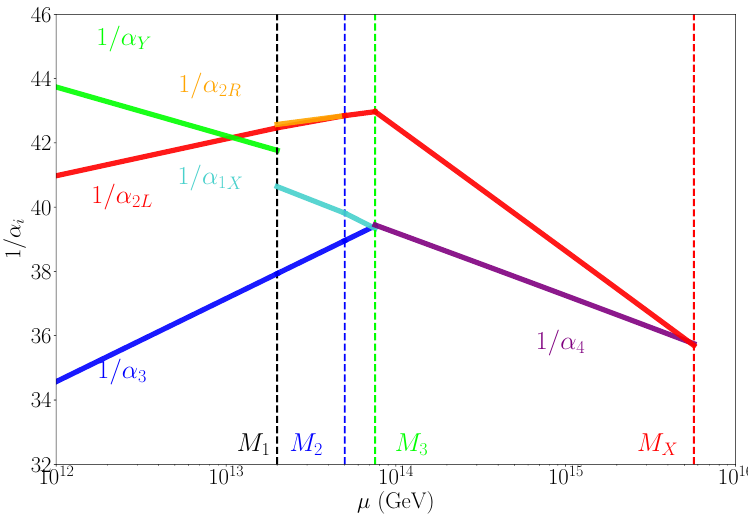
Figure 2 . The RG running of gauge couplings in the breaking chain SO(10) → G 3 → G 2 → G 1 → G SM . BP1 with the first and second lowest intermediate scales are fixed at M 1 = 2 × 10 13 GeV and M = 5 × 10 13 GeV, the remaining scales M 2 determined by the gauge unification at M